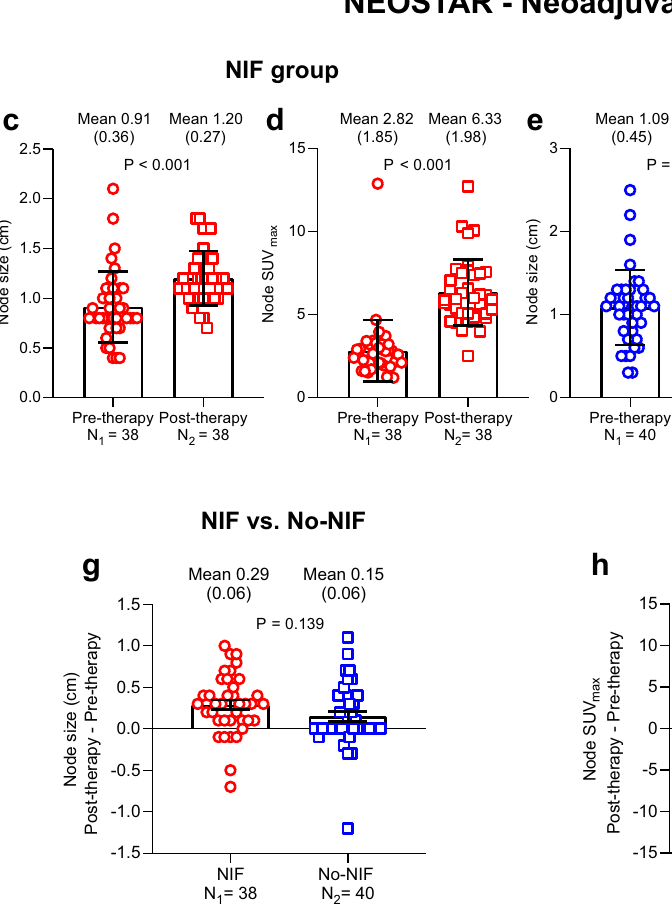
patients with NIF than in nodes from patients with No-NIF (Fig. 4a – f, Supplementary Table 2, and Supplementary Data 1; Source Data fi le). Analysis of differentially expressed genes showed an enrichment of immune-related genes in nodes from patients with NIF as compared to nodes of patients with No-NIF (Fig. 4g; Source Data fi le). To determine whether the differentially expressed immune genes in nodes of patients with NIF were associated with speci fi c biological processes or molecular functions that may provide insight into the mechanisms governing NIF, we performed gene set enrichment analysis (GSEA) on the resected nodes. We noted that genes usually associated with favorable responses to ICIs, such as the antigen processing and presentation and the interferon gamma (IFN- γ ) signaling and response pathways, were signi fi cantly upregulated